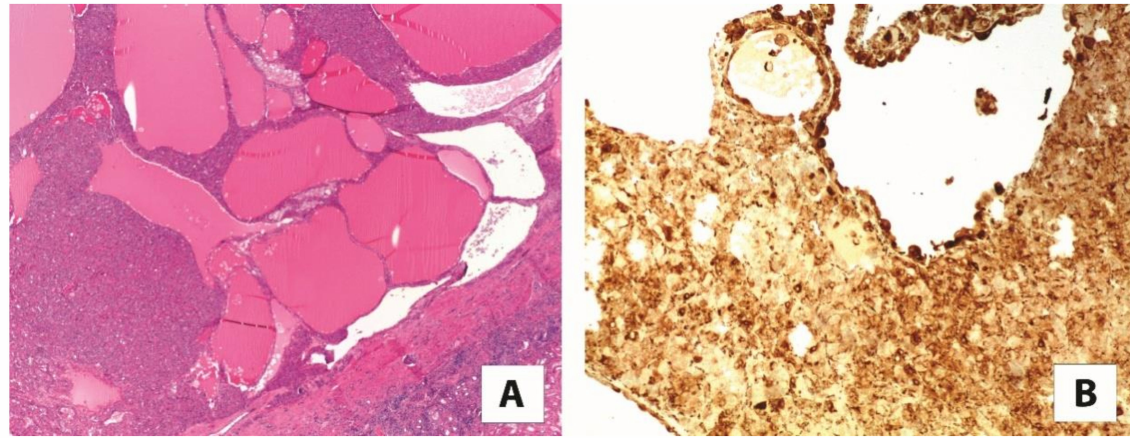
Figure 4. ( A ) The most common morphological features of eosinophilic solid and cystic renal cell carcinoma (2 × ). ( B ) The neoplastic cells are reactive for cathepsin K (10 ×